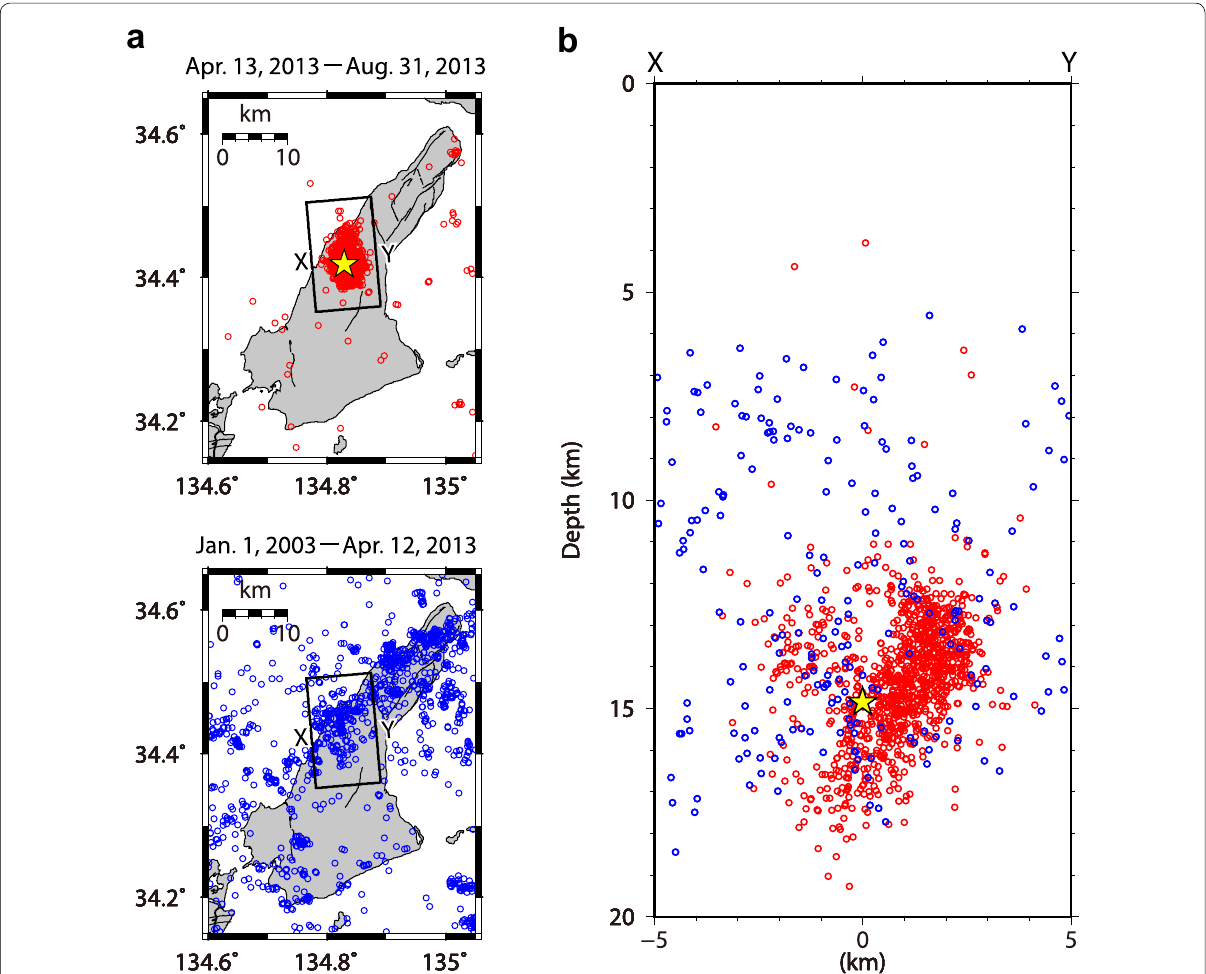
Fig. 2 Seismic activity in Awaji Island shallower than 20 km based on JMA catalog. a Map view and b cross-section. Blue and red circles correspond to M0 earthquakes before (1 January 2003–12 April 2013) and after the 2013 Awaji Island earthquake (13 April 2013–31 August 2013), respectively. + A yellow star shows the